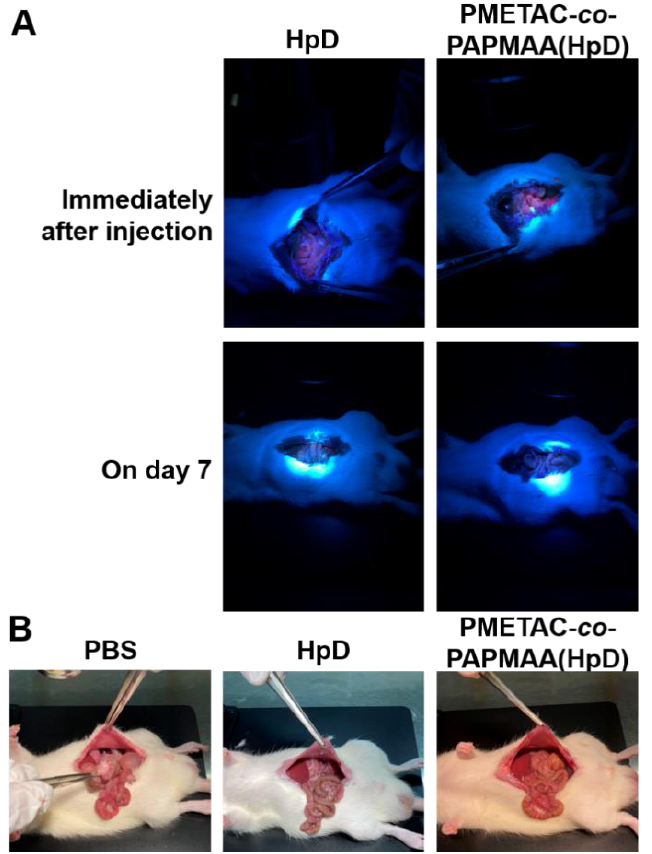
Figure 5. Fluorescent detection and confirmation of tissue adhesion after intraperitoneal injection of HpD and PMETAC- co -PAMPAA(HpD) . ( A ) Fluorescent detection of HpD and PMETAC- co -PAMPAA(HpD) on day 7 after intraperitoneal injection. ( B ) Abdominal tissue adhesion on day 7 after intraperitoneal injection of PBS, HpD, and PMETAC- co -PAMPAA(HpD).